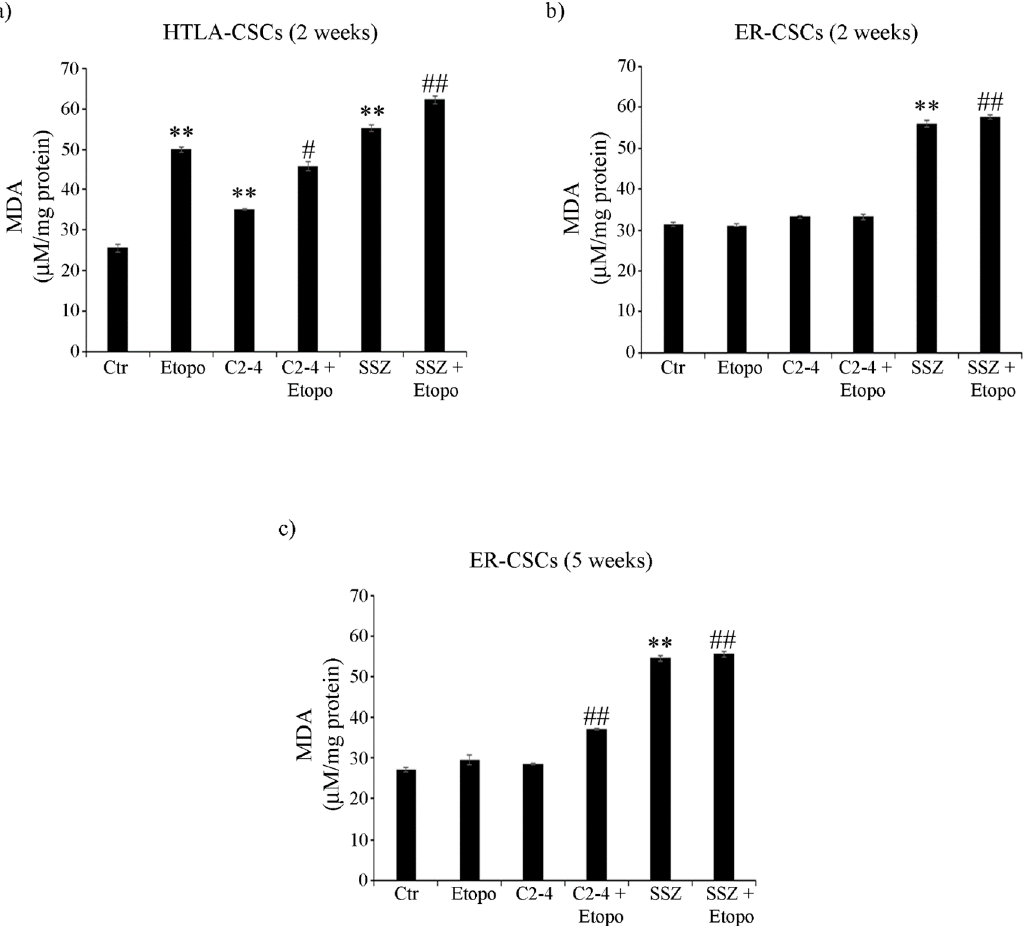
Figure 8. MDA production in both CSC populations treated for two ( a , b ) or five weeks ( c ). HTLA-CSCs and ER-CSCs were treated three times a week with 0.1 µM C2-4, with 5 µM SSZ or with 1.25 µM Etoposide, administered once a week alone or in combination with C2-4 or SSZ. Results were reported as µM/mg protein. Bar graph summarizes quantitative data of means ± S.E.M. of three independent experiments. ** p < 0.01 vs. untreated CSCs (Ctr); # p < 0.05 vs. Etoposide-treated CSCs; ## p < 0.01 vs. Etoposide-treated CSCs.